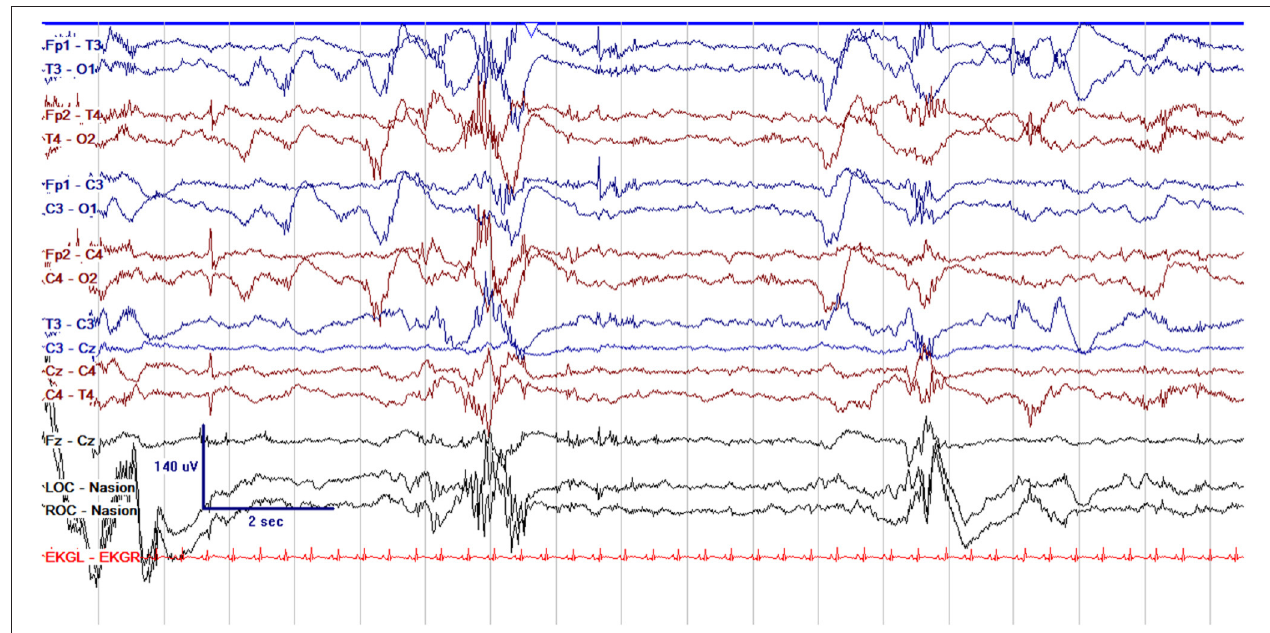
FIGURE 1 | Normal cEEG in a preterm neonate, a 2 day old former 29 + 3 week gestational age (GA) [29 + 5 week post-menstrual age (PMA)] neonate with normal discontinuity for gestational age. In neonates with GA < 30 weeks, interburst intervals can be up to 35s and < 25 µ V. In GA 30–33 weeks, interburst intervals can be a maximum of 20s with voltage < 25 µ V. In 34–36 week GA neonates, interburst intervals can be up to 10s and ∼ 25 µ V.